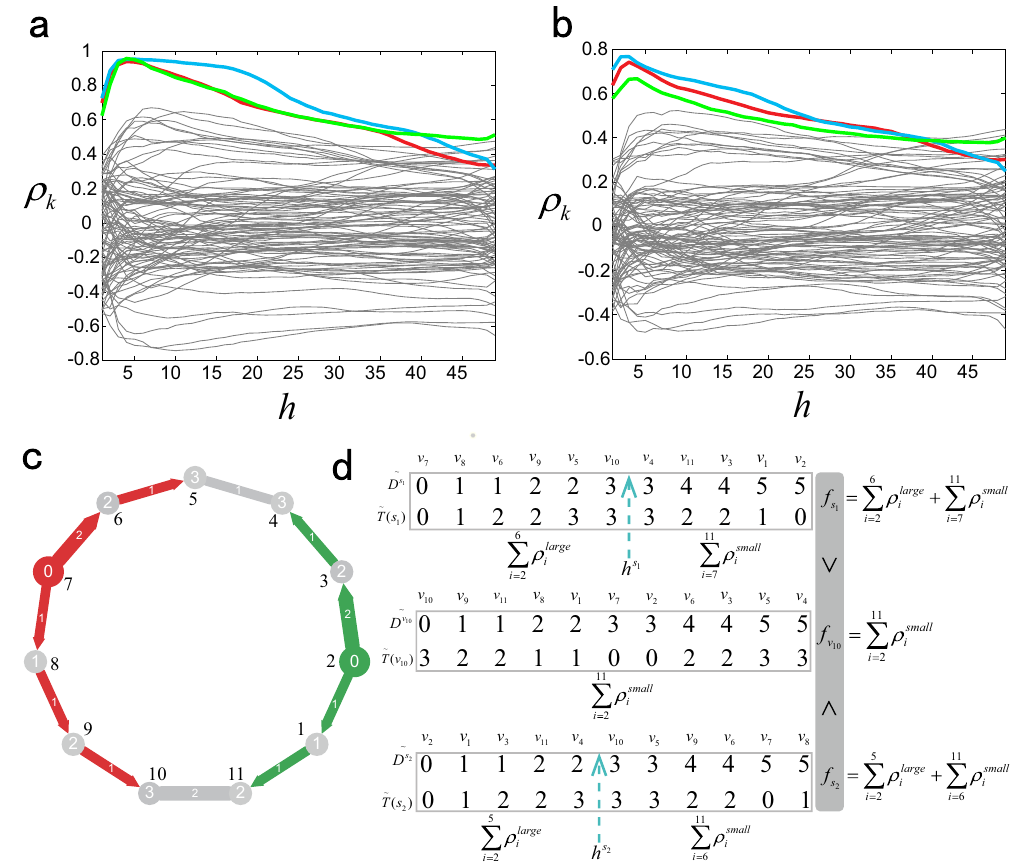
Figure 2. Description of multi-source location method. ( a )–( b ) are the relationship between Pearson centrality ρ k and threshold h , we simulate diffusion and SI dynamics on ER random network with n = 100 and the average degree is � k � = 4 . ( a ) is diffusion dynamics with u = 2 and σ = 0.25 and ( b ) is SI with informed rate as (cid:31) = 0.5 . Three sources and fifty percent observer nodes are selected randomly. Abscissa is threshold h of ordinate is pearson centrality ρ k . Different curves correspond to different nodes, three curves with red, blue and green corresponding to three source nodes. ( c ) is an example of network. Numbers in the center of nodes are their informed time and numbers beside the nodes are their labels. The red node (node v 7 ) is source s 1 and the green node (node v 2 ) is source s 2 , their initial time are both 0. Red and green links with arrows represent the direction of message propagation from source s 1 and s 2 respectively. ( d ) is description of calculating index f . We consider the f value of source s 1 , node v 10 and source s 2 of network in ( a ). We sort DDD s 1 , DDD v 10 and DDD s 2 in ascending order